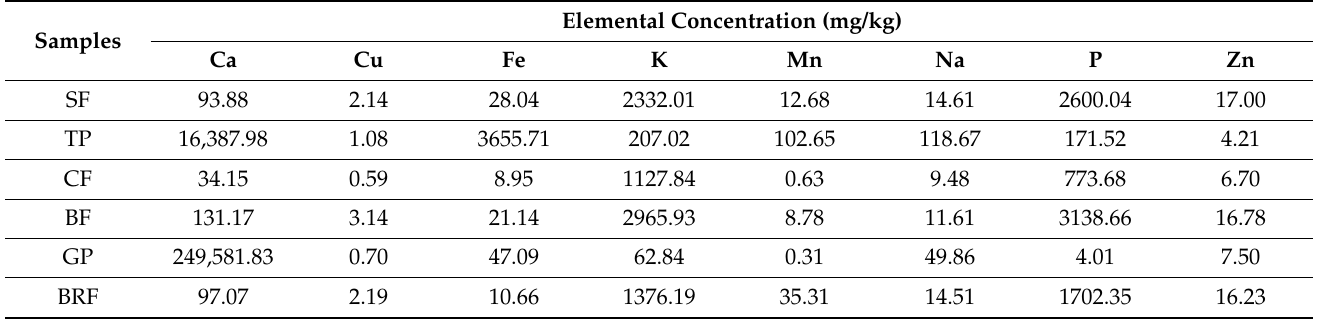
Table 1. The elemental concentration of six kinds of samples were measured by